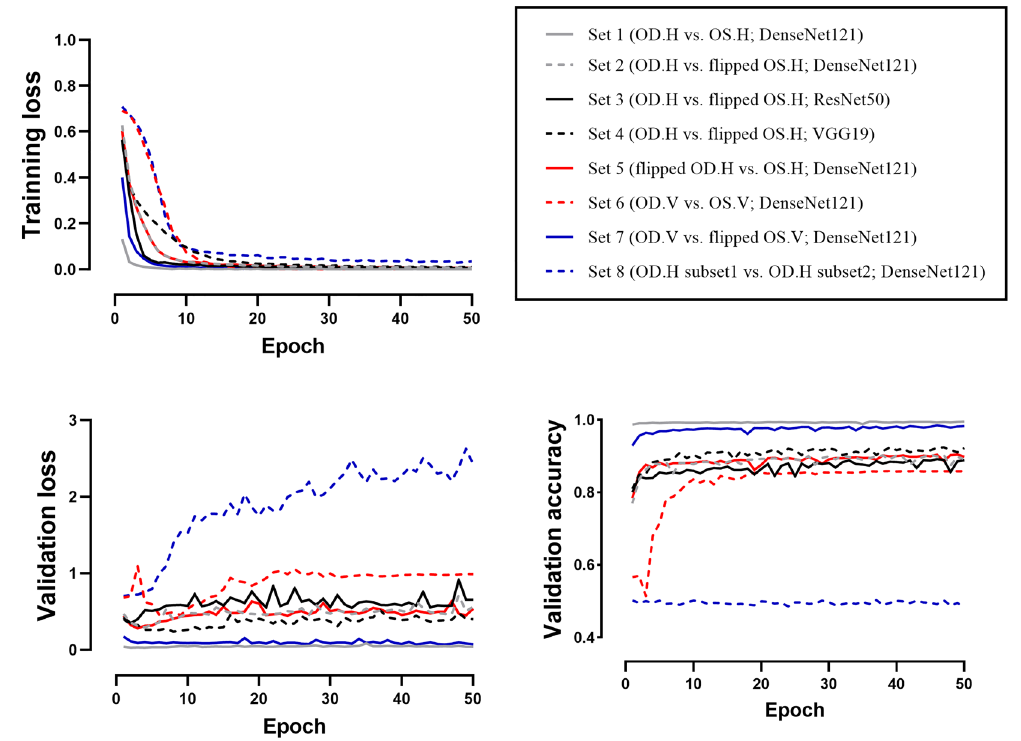
Figure 1. Training and validation results. The training loss of Sets 1–7 approached zero. In Set 1, images of right and left eyes were easily distinguished, with the validation loss approaching zero and the validation accuracy thus approaching 1.0. In Sets 2–5, similar validation loss (~ 0.4) and validation accuracy (~ 90%) were obtained. For Set 6, which consisted of vertical images, the accuracy was slightly inferior compared to Sets 2–5. Set 7 showed the second-highest validation accuracy. In contrast to Sets 1–7, overfitting was observed in Set 8; in this set, training loss converged whereas validation loss diverged. The validation accuracy of Set 8 was around 0.5 and failed to improve over the learning period. OD oculus dexter, OS oculus sinister, H horizontal, V